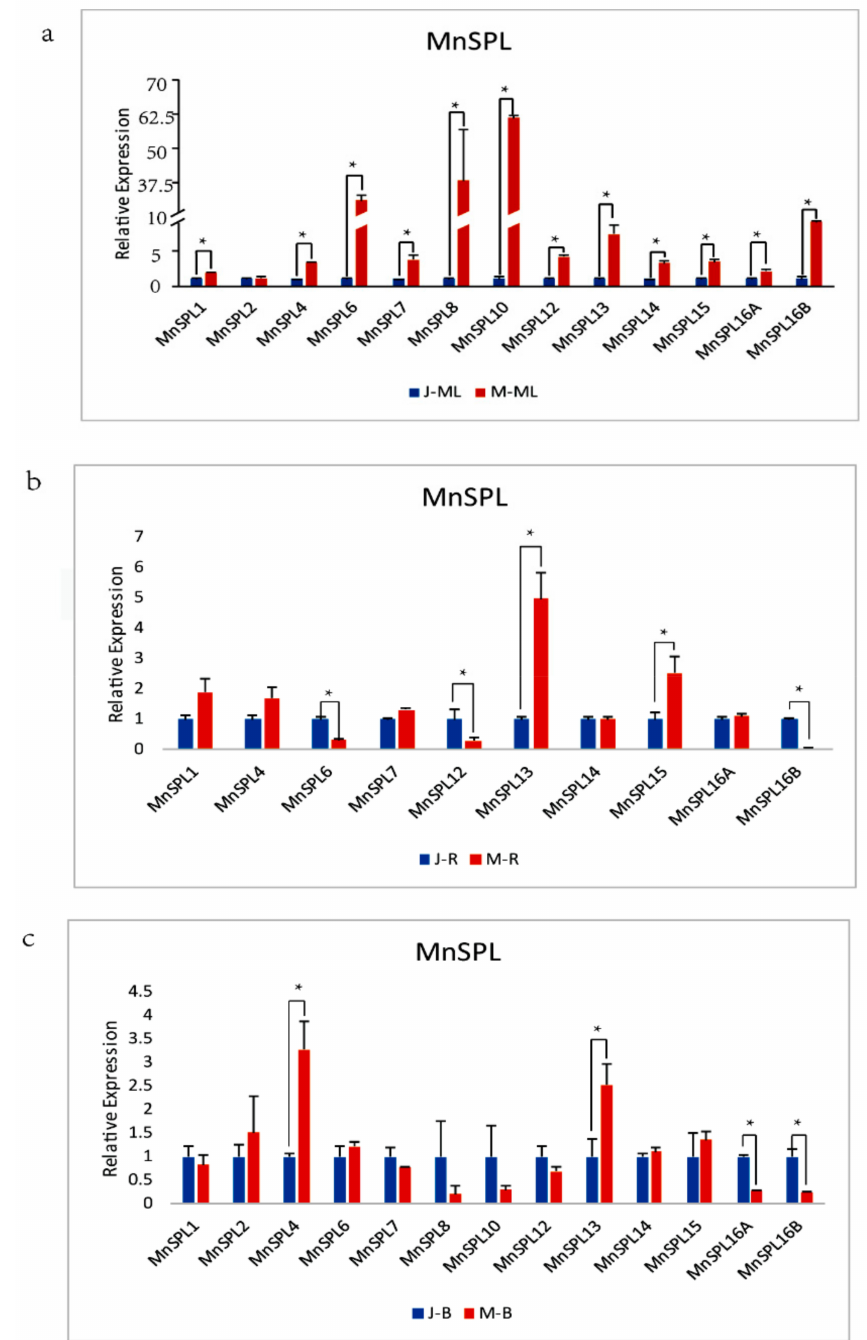
Figure 6. The expression profiles of MnSPL genes in the juvenile and mature phases of 3 mulberry tissues. ( a ) Leaves, J-ML: mature leaves at the juvenile phase of mulberry, M-ML: mature leaves at the mature phase of mulberry. ( b ) Roots, J-R: roots at the juvenile phase of mulberry, M-R: roots at the mature phase of mulberry. ( c ) Bark. J-B: bark at the juvenile phase of mulberry, M-B: bark at the mature phase of mulberry. Values represent the mean ± SD of 3 biological replicates and were statistically analyzed (independent samples t -test): * p <